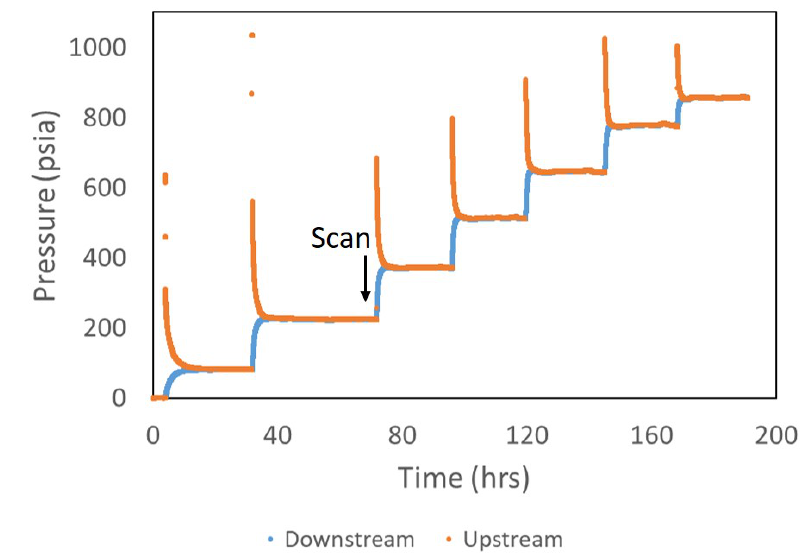
Figure 4. Pressure history of all Kr pressure pulses for the Eagle Ford sample. The black arrow illustrates that CT acquisitions are taken at the end of each pulse. This specific example shows a CT scan acquired at the end of Pulse 2. Slight unsteadiness in equilibrium pressure is observed in the last few pulses due to room temperature fluctuations that have greater influence at higher